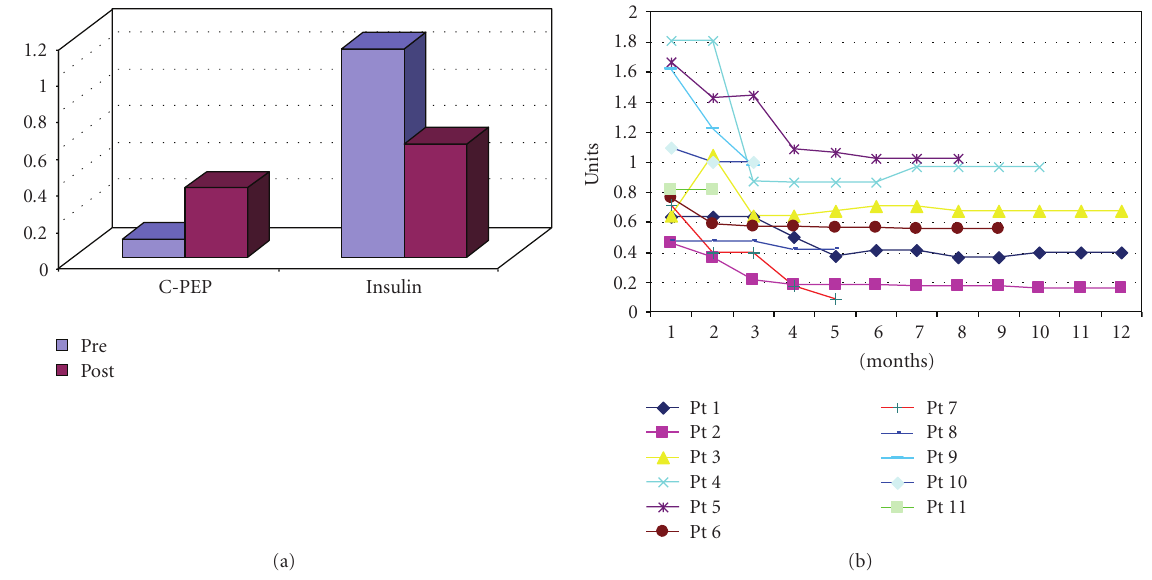
Figure 3: (a) Comparison of S.C-peptide levels and insulin requirement pre and post (7 months) stem cell transplantation. (b) Followup of exogenous insulin requirement